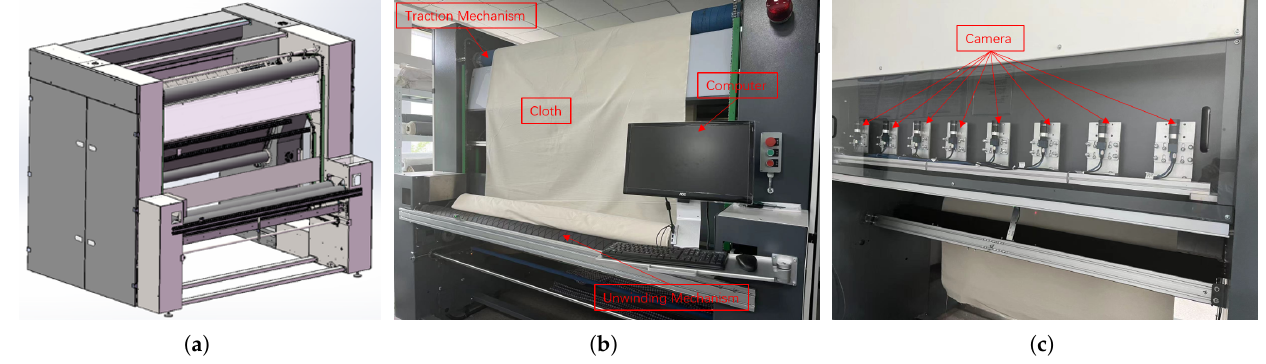
Figure 6. Hardware system. ( a ) Overall diagram of the equipment; ( b ) front view of the equipment; ( c ) rear view of the